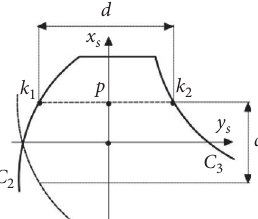
F IGURE 6: Coordinate transformation of concave tooth pro fi